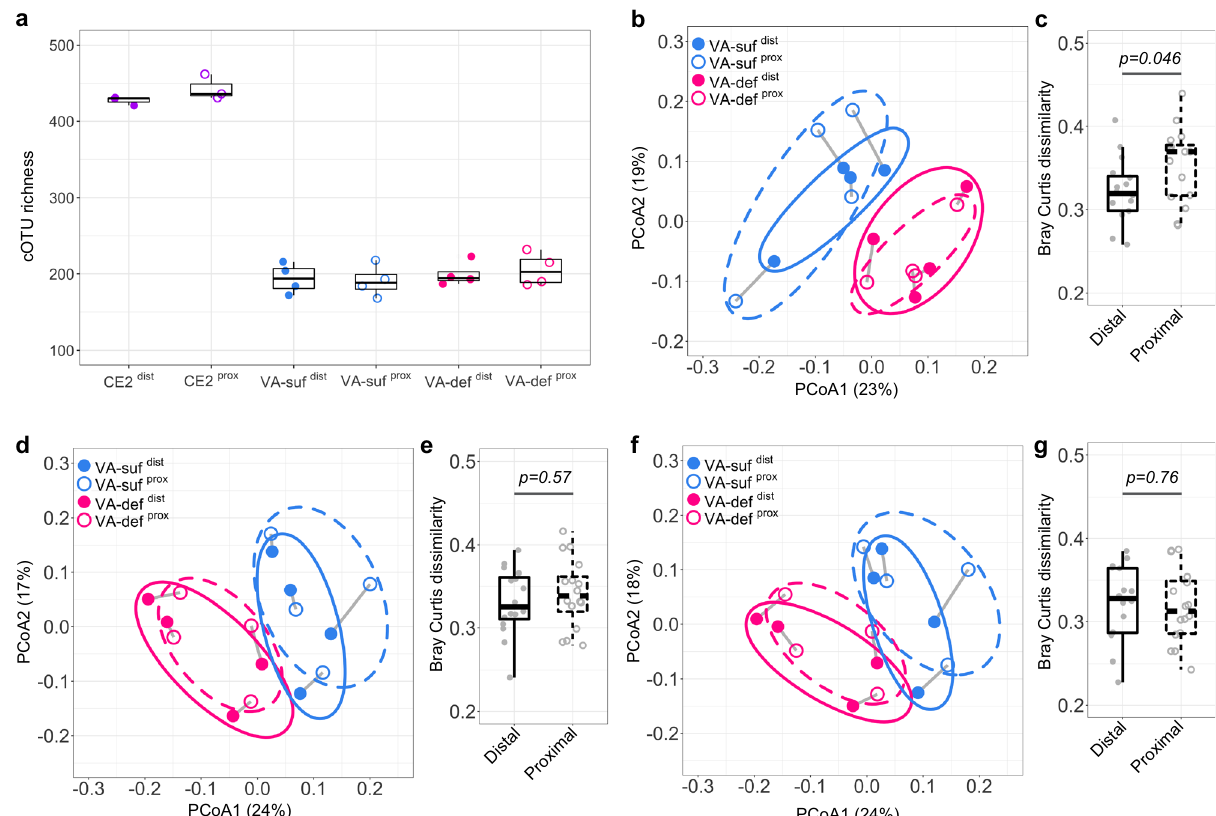
Fig. 5 cOTU richness and Bray-Curtis dissimilarity of the murine cecal microbiotas. a The cOTU richness of each cell-sample determined by subsampling 6608 cells using the function rarefy in the R package Vegan. CE2, CE2 nutriment group; VA-suf, VA-suf fi cient group; VA-def, VA-de fi cient group; dist and prox, locations. b , d , and f , Principal coordinate analysis (PCoA) of Bray-Curtis dissimilarities calculated based on the relative cell abundances of cOTUs ( b ), ASVs ( d ), and OTUs ( f ) between each pair of cell-samples in the VA group. Labels, same as ( a ); gray line, linkage from the same mouse; circles, 95% con fi dence ellipses for each group. c , e , and g , Quantitative comparison of Bray-Curtis dissimilarities in b , d , and f , respectively. Distal, all possible pairs from VA-suf dist and VA-def dist , respectively; Proximal, all possible pairs from VA-suf prox and VA-def prox , respectively. Boxes in a , c , e , and g represent 25th to 75th percentiles (the interquartile range), horizontal black lines indicate medians, and whiskers show 1.5 times the interquartile range ( n = 3 for CE2 dist and CE2 prox ; n = 4 for VA-suf dist , VA-suf prox , VA-def dist , and VA-def prox ; n = 16 for Distal and Proximal). P values were calculated by the Kruskal – Wallis rank-sum test. Source data are provided as a Source Data fi